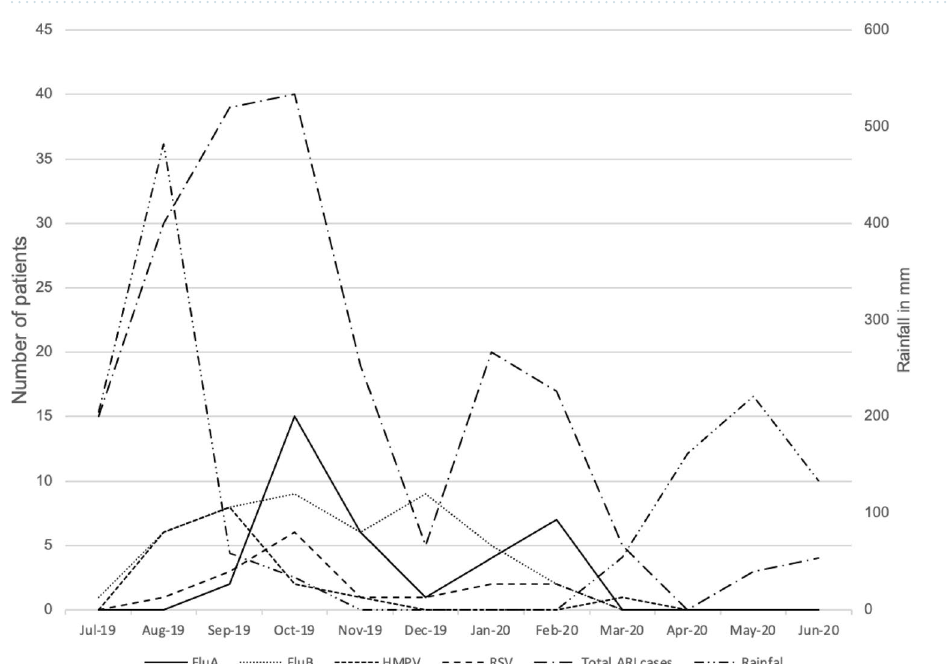
Figure 3. Temporal distribution of detection of influenza A virus, influenza B virus, human metapneumovirus, and respiratory syncytial virus in included ARI patients in relation to monthly average rainfall. Xiengkhuang rainfall data from Department of Meteorology and Hydrology, Lao